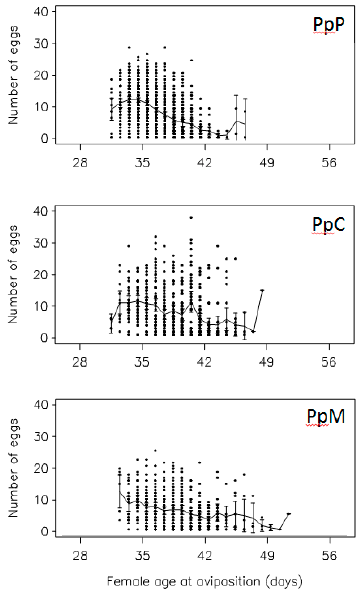
Figure 2. Changes in oviposition during female reproductive period: Females reared on common bean (PpP group) were allowed to deposit eggs on chickpea (PpC group) or mung bean seeds (PpM group). Raw data are shown as the individual points, with the line falling on the mean for those data with the SE of that mean.